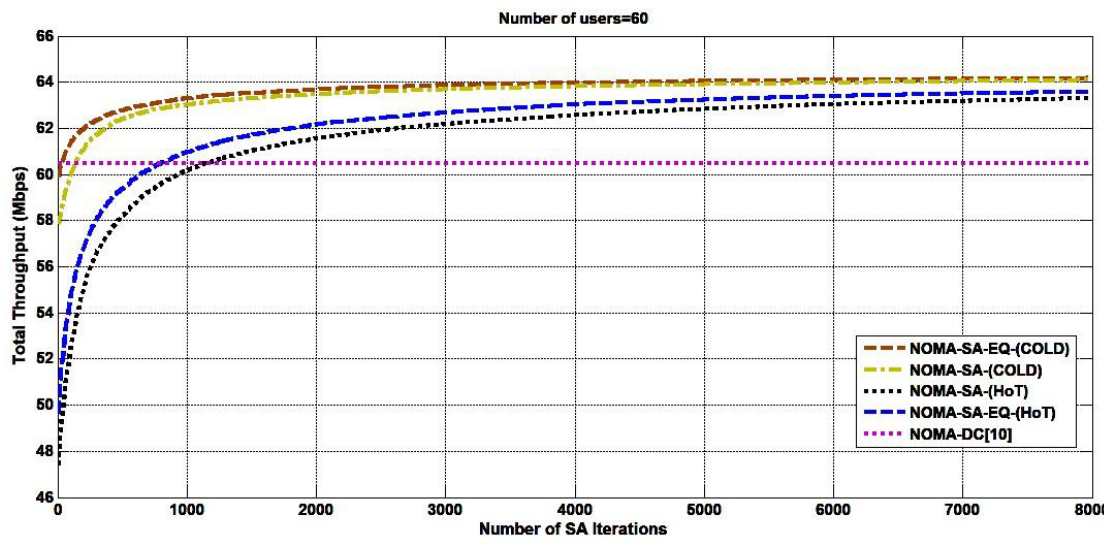
Figure 5. Convergence and Iterations.